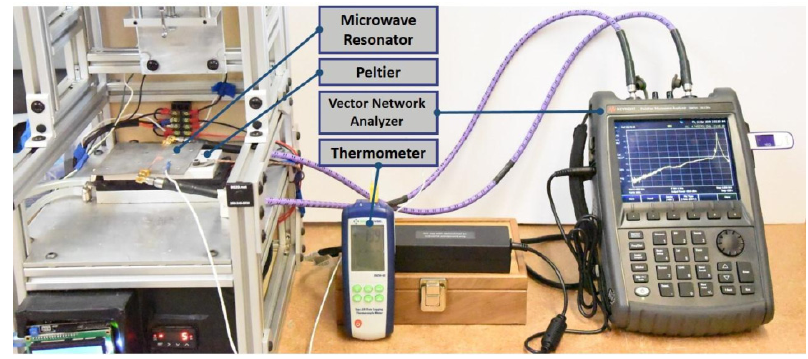
Figure 8. The frost detection device based on microwave.